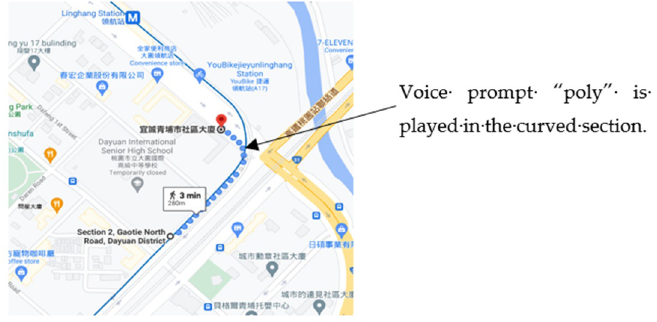
Figure 13. The route that the visually impaired person